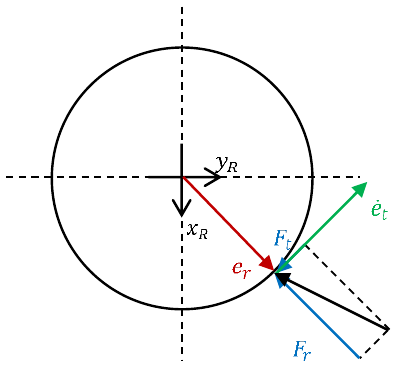
Figure 3. Snapshot of the kinetics of a circular orbit. The global stiffness k g , r in direction of journal orbit radius e r and the main damping . c g , t in direction of tangential orbit velocity e t are calculated according to Equation (10): F r F t k g , r = , c g , t = . e r e t Based on Equation (10), the relation of the stiffness and damping matrix in cartesian x-y- coordinates is established in the following. The assumption of a circular orbit leads to the demand that the 2 × 2 stiffness and damping matrices are invariant due to rotations ϕ of the coordinate system, as expressed in Equation (11):